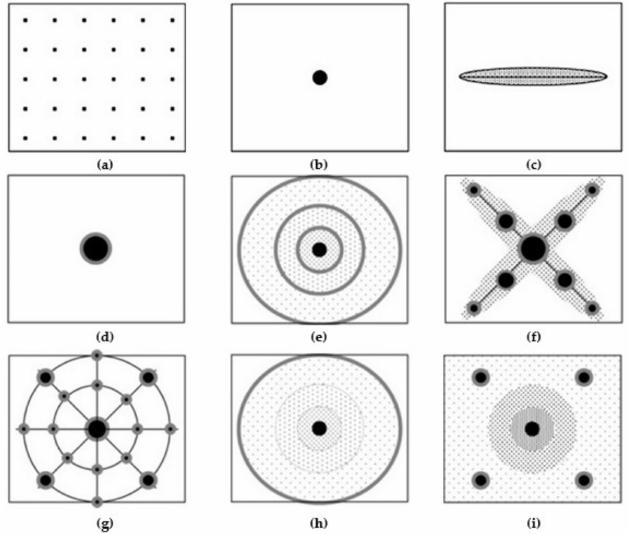
Figure 1. Various urban forms. ( a ) areal urban structure; ( b ) point urban structure; ( c ) linear urban structure; ( d ) compact urban structure; ( e ) dispersed urban structure; ( f ) corridor urban structure; ( g ) multinucleated urban structure; ( h ) fringe urban structure; ( i ) ultra-urban